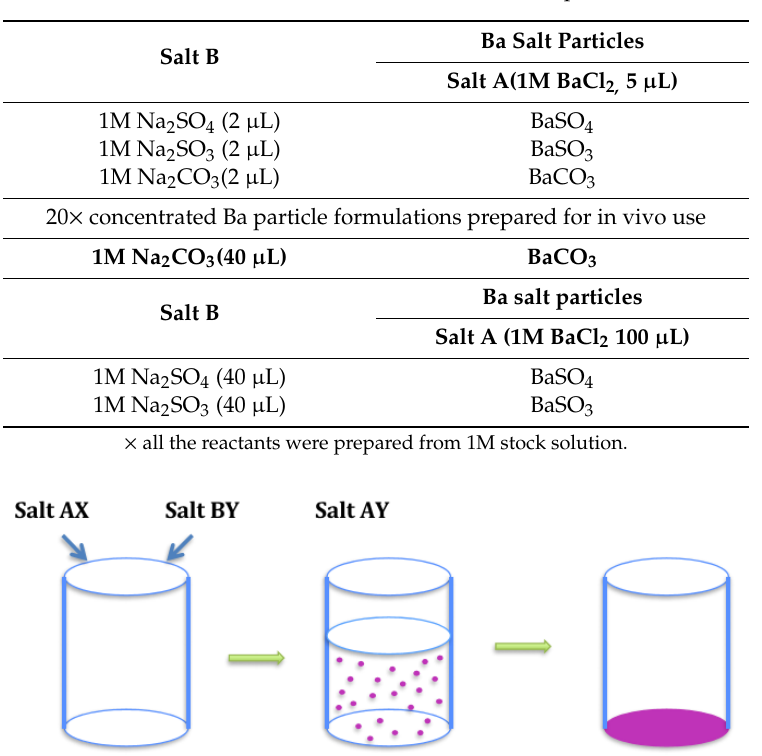
Table 1. Formulations of three di ff erent Ba salt particles.